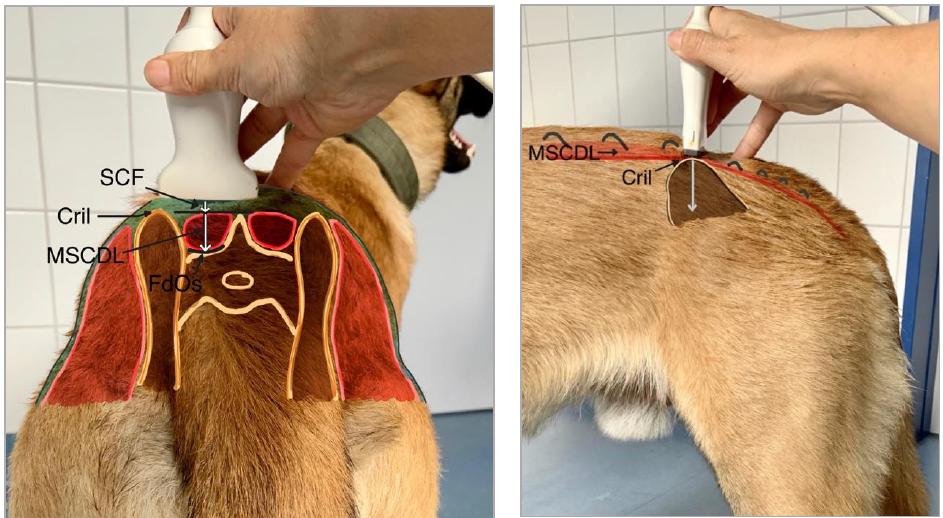
Figure 1. Position of the ultrasound probe on an upright standing dog, Cril: Crista iliaca, FdOs: Facies dorsalis of the Os sacrum, MSCDL: Musculus sacrocaudalis dorsalis lateralis, SCF: subcutaneous fat